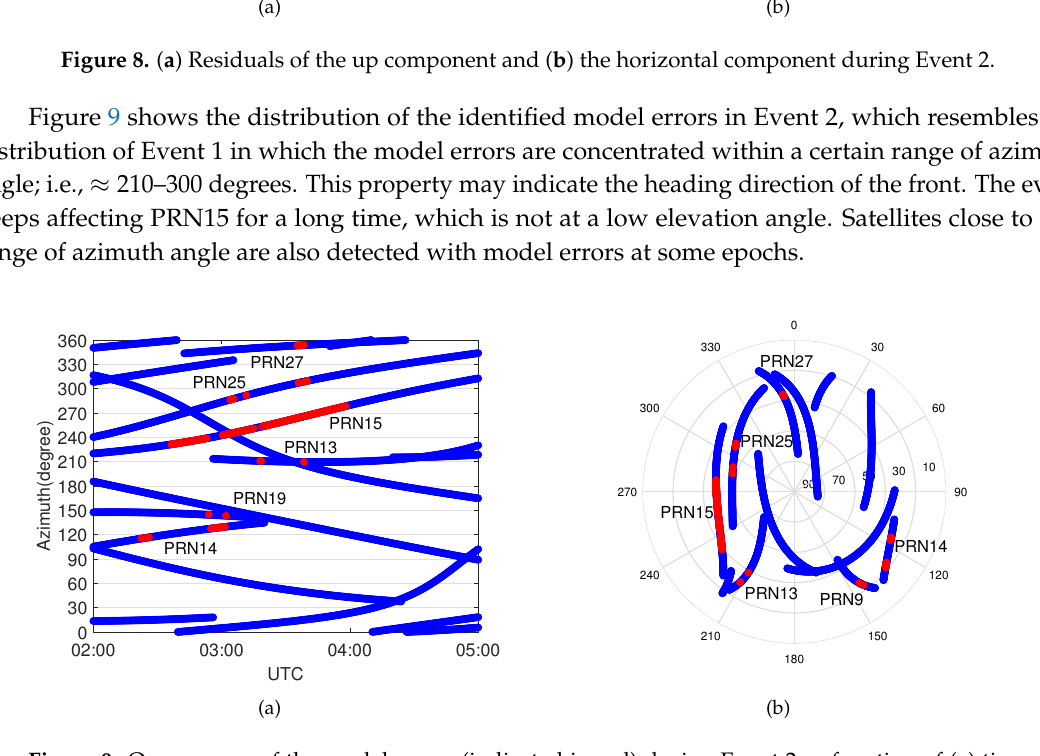
Figure 9. Occurrences of the model errors (indicated in red) during Event 2 as function of ( a ) time and azimuth and ( b ) elevation and azimuth (skyplot). The blue lines represent the trajectories of the satellites, and the red points indicate that model errors are identified at those